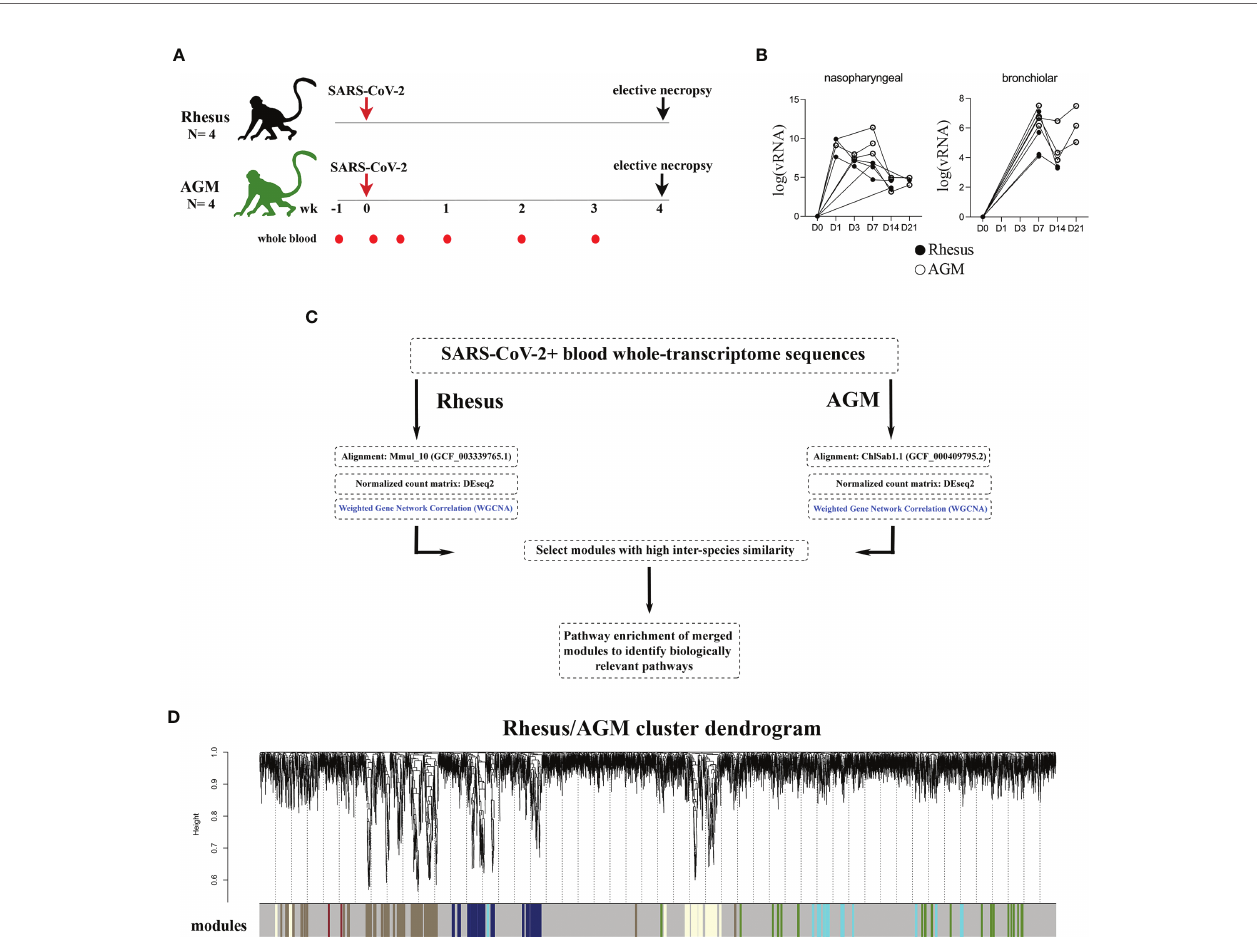
FIGURE 1 | WGCNA reveals robust transcriptional alterations in blood of SARS-CoV-2 infected AGMs and RMs. (A) Schematic of study design. Arrows represent SARS-CoV-2 challenge. Red dots represent sampling timepoints of whole-blood RNA sequencing at baseline, 1, 3, 7, 14, and 21 days post-infection. (B) SARS- CoV-2 RNA levels in nasopharyngeal and bronchial brushes over time. (C) Schematic of computational pipeline employed to uncover groups of genes sharing high inter-species similarity that behaved in a coordinated fashion in response to SARS-CoV-2. (D) Clustering dendrogram of genes with dissimilarity based on topological overlap, with gene modules assigned by colors.